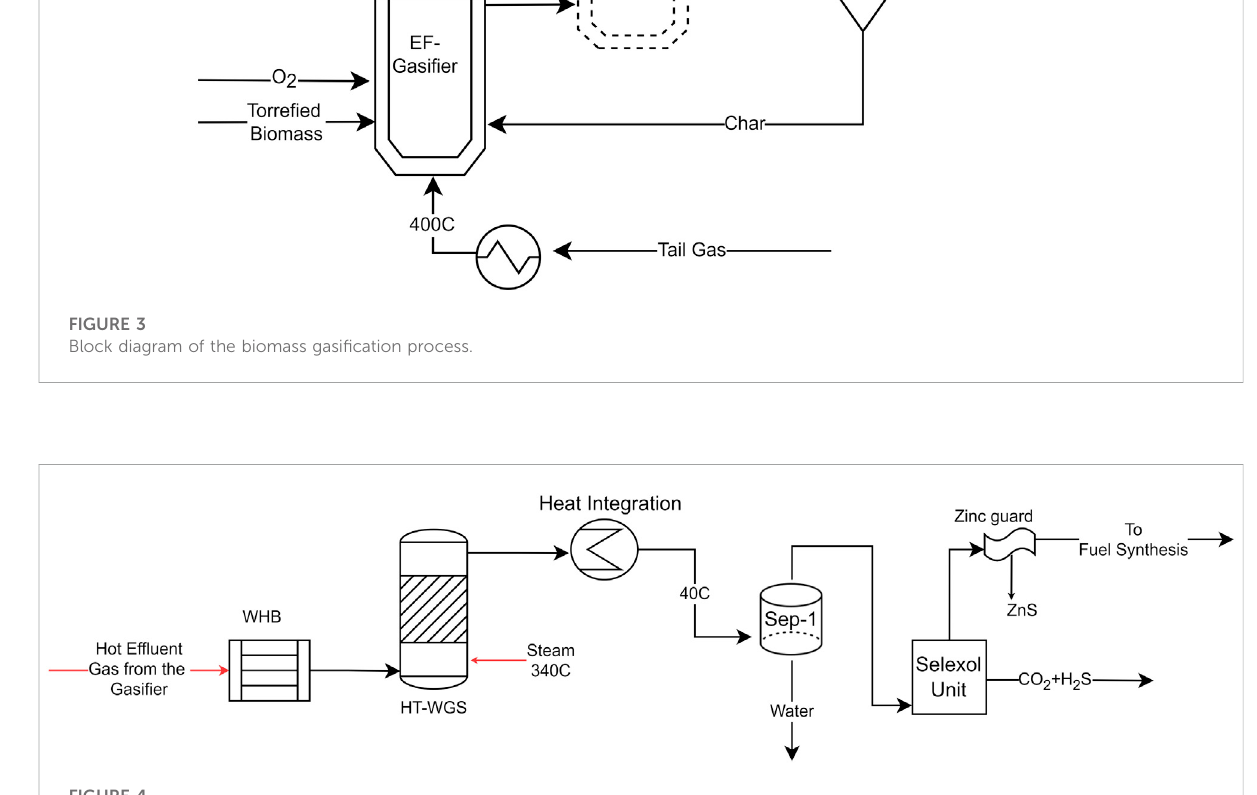
FIGURE 4 Block diagram for Syngas clean-up and conditioning in Case I and II. Heat integration here refers to the utilization of energy available in the hot ef fl uent gas for heating O 2 from ASU (Case I and II), heating recycled tail gas to 400 ° C before it is fed to the gasi fi er (all cases). For Case III-VI, the excess heat is utilized to prepare the boiler feed water for WHB.